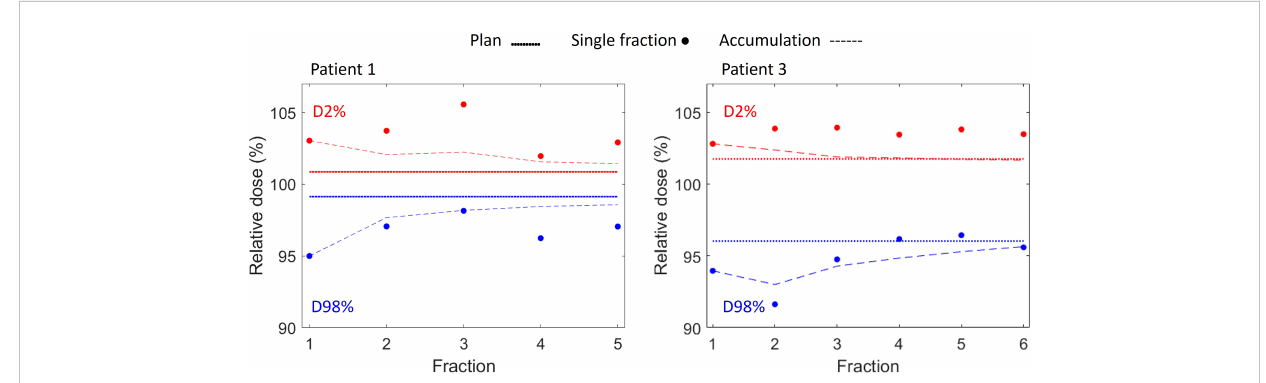
FIGURE 6 CTV D98% (blue) and D2% (red) for planned dose (solid lines), for reconstructed single fraction doses (dots) and for the cumulative reconstructed dose of 1-5 fractions (Patient 1, left) and 1-6 fractions (Patient 3, right) (dashed curves).